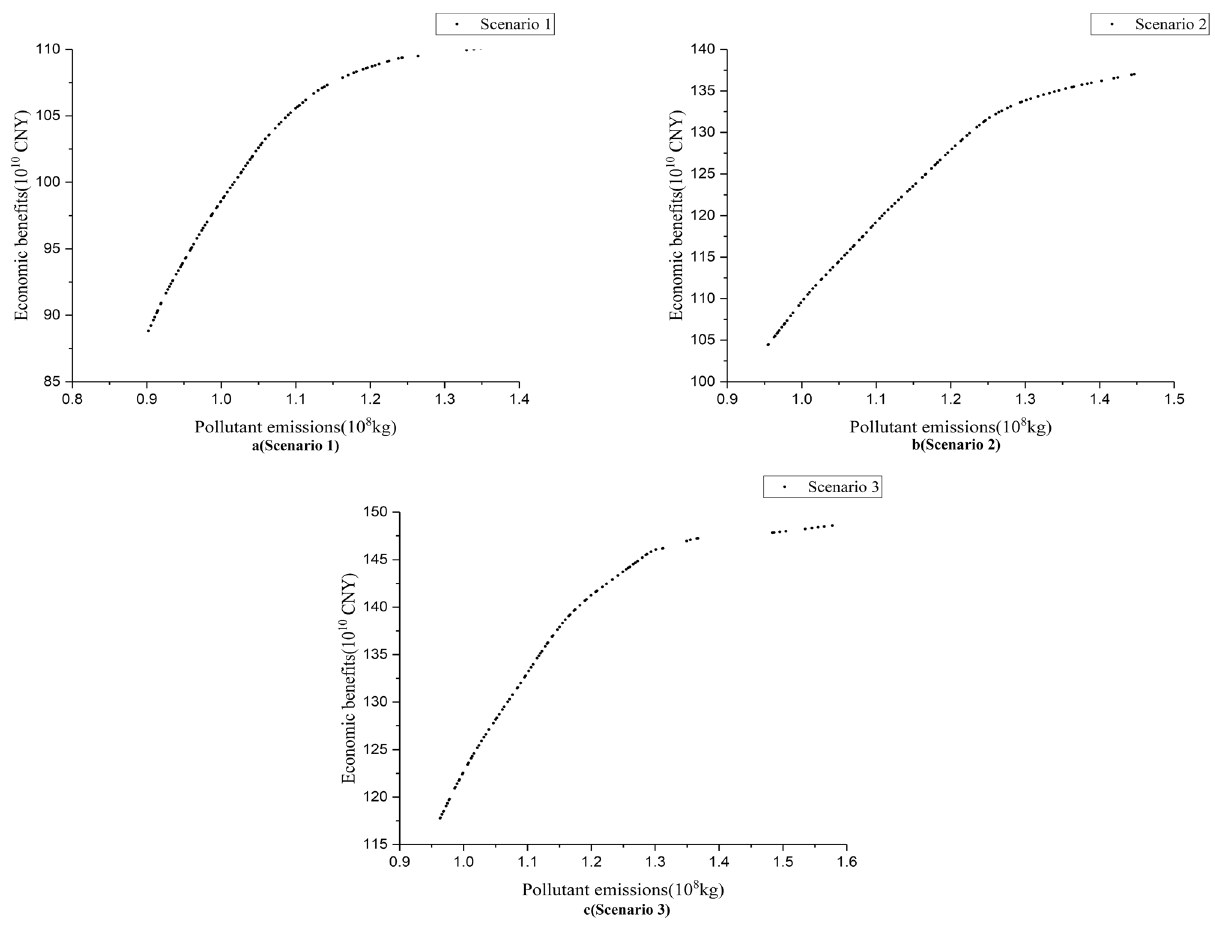
Figure 4. The Pareto frontier of water resources allocation.